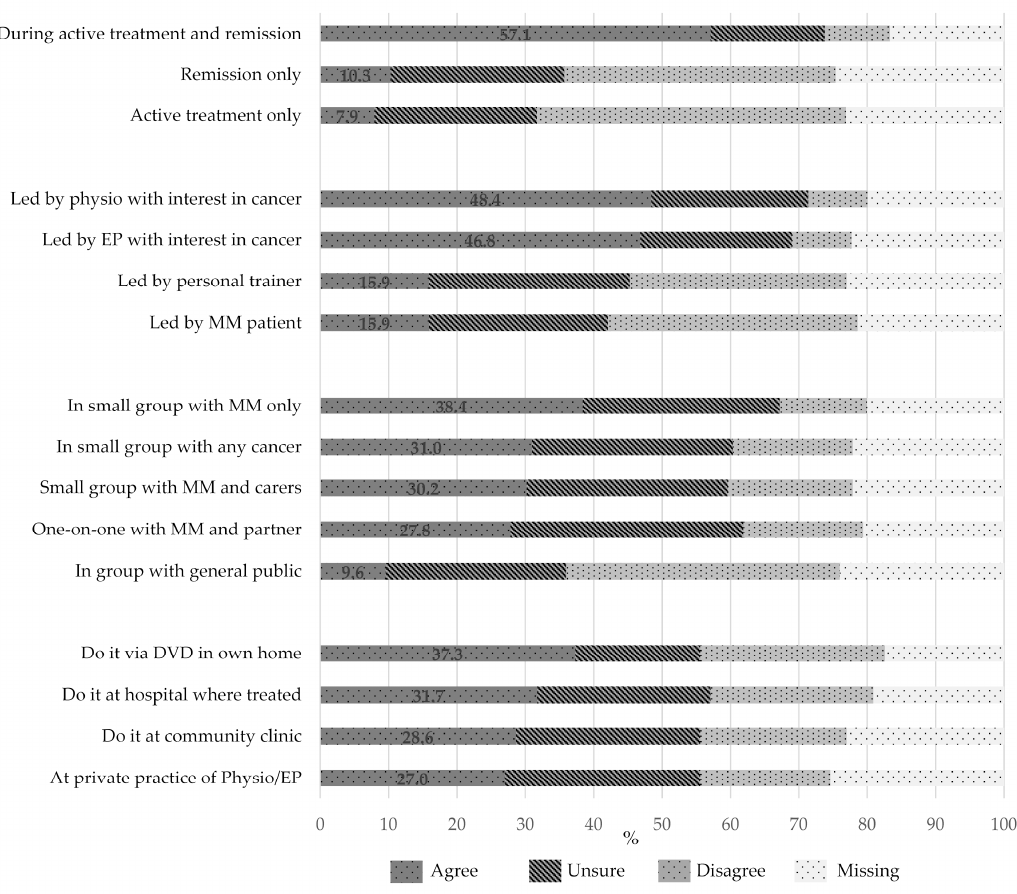
Figure 3. Preferences of respondents for timing, location, and composition of an exercise program ( n = 126). Physio, physiotherapist; EP, exercise physiologist; MM, multiple myeloma.